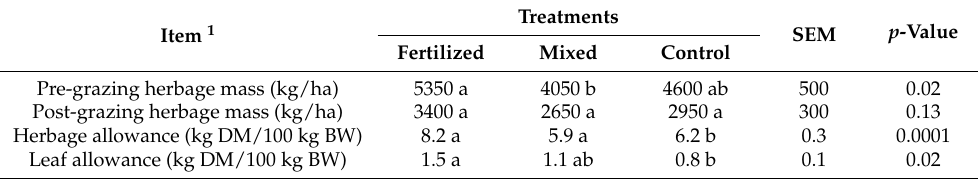
Table 4. Herbage mass, herbage, and leaf allowance of palisade grass pastures fertilized with urea (150 kg N/ha/year), mixed with pintoi peanut (mixed), and non-fertilized (control). Average of 2 years of evaluation of 5 grazing cycles ( n =